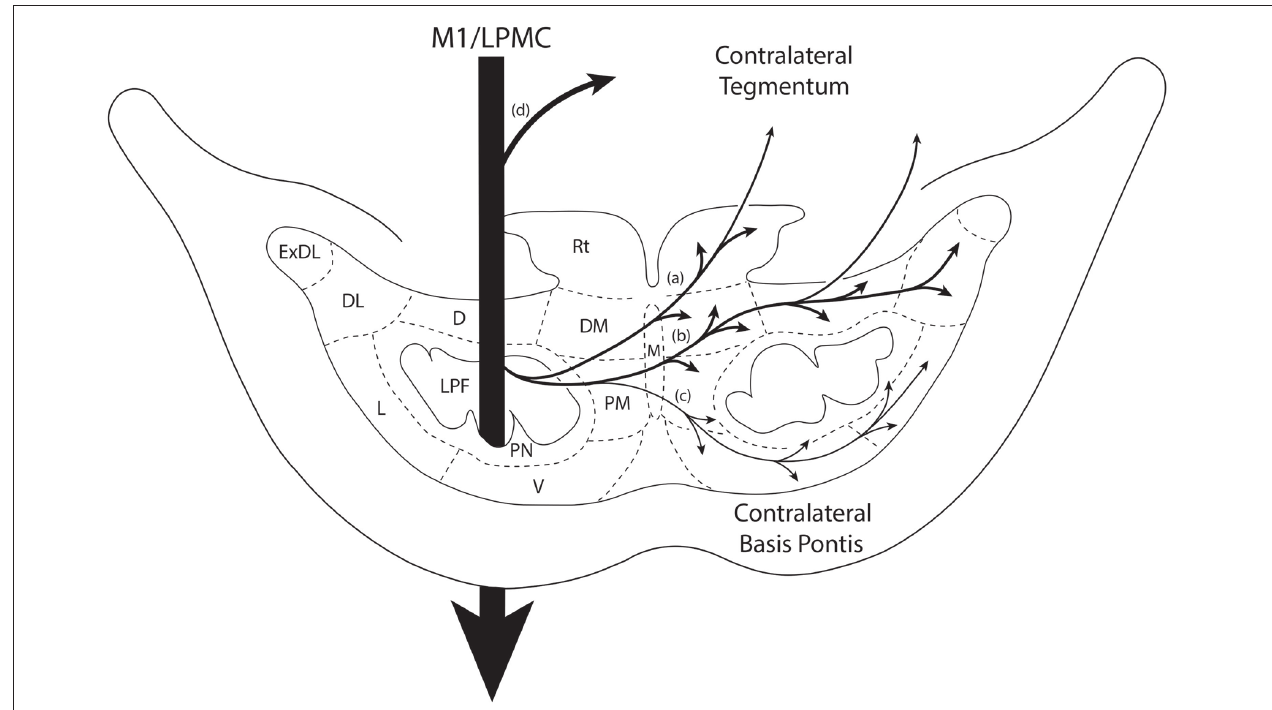
FIGURE 7 | Summary diagram illustrating the main pathways taken by labeled axons to innervate the gray matter of the contralateral basis pontis. The thick descending arrow denotes the LPF. One major route emerges from the LPF and courses dorsally through the median nucleus (a,b) to innervate the dorsomedial, reticular, dorsal, dorsolateral and dorsolateral extreme PN. This pathway also contains a contingent of fibers that continue dorsally through the contralateral basis pontis to enter and innervate gray matter targets in the contralateral pontine tegmentum. Injections in the lateral premotor cortex (LPMC) also gave rise to a weaker, ventrally directed pathway (c). Also illustrated is the commonly recognized route taken by fibers from the LPF that innervate the contralateral pontine tegmentum (d). Specifically these fibers emerge from the LPF, enter the ipsilateral tegmentum, then cross the midline within the tegmentum proper. Abbreviations: D, dorsal nucleus; DL, dorsolateral nucleus; DM, dorsomedial nucleus; ExDL, extreme dorsolateral nucleus; L, lateral nucleus; M, median nucleus; PM, paramedian nucleus; PN, peduncular nucleus; Rt, reticular nucleus; V, ventral